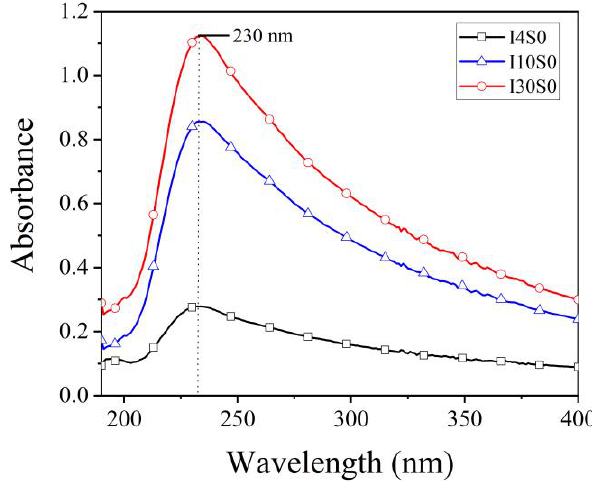
Figure 14. UV-VIS spectra of suspensions recycled from tap water electrolyte.